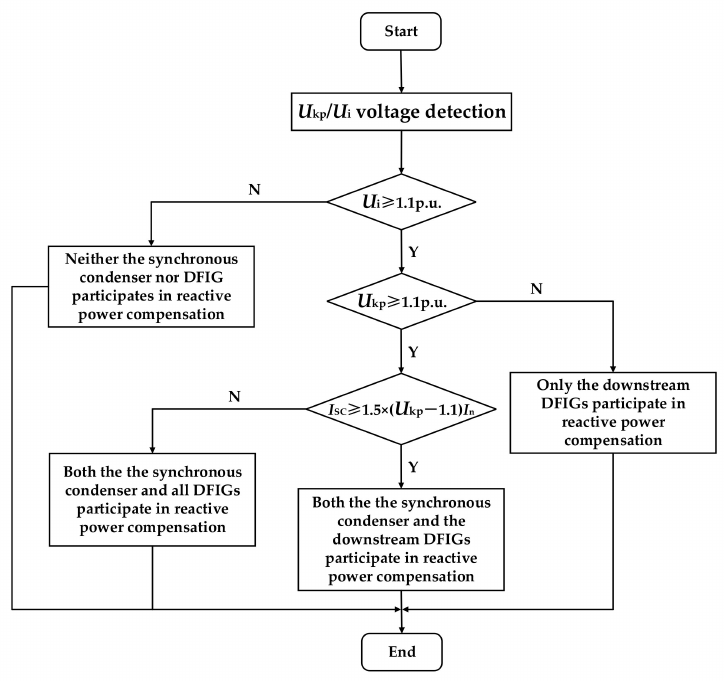
Figure 13. The coordinated control flow chart.